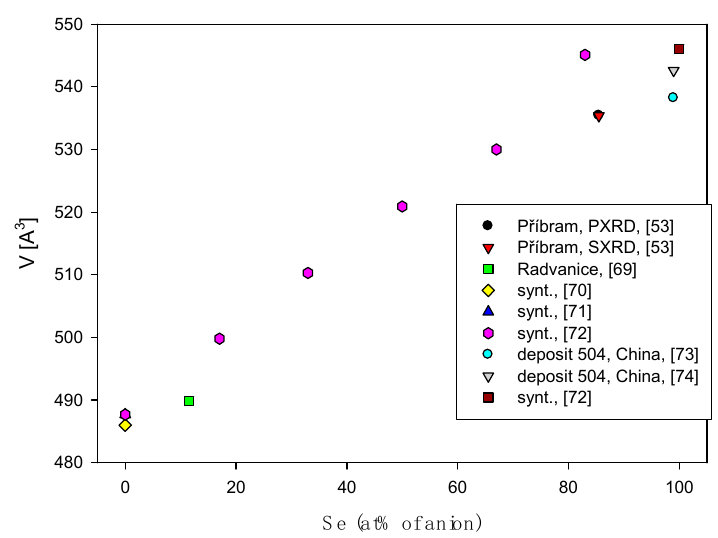
Figure 5. Se contents (at% of anion) vs. the unit-cell volume graph for the members of the stibnite-antimonselite solid solution. PXRD: X-ray powder diffraction; SXRD: single crystal X-ray diffraction [69–74].